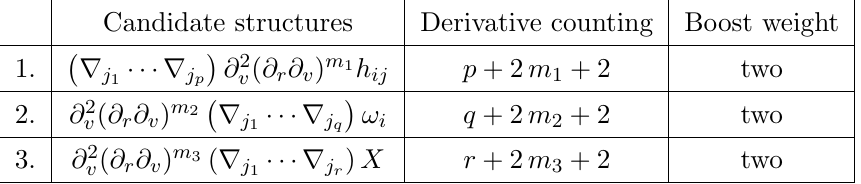
Table 4 . The list of ‘o(cid:11)-equilibrium’ and ‘boost-weight= 2’ data built out of the basic building